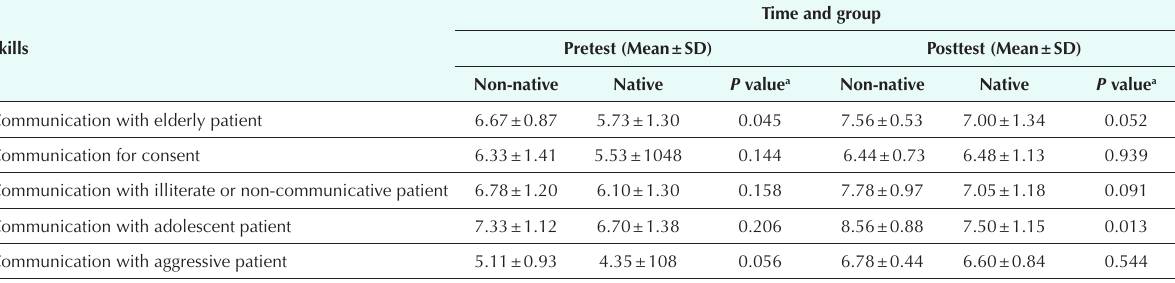
Table 5. Comparisons of native and non-native participants respecting the mean scores of CSs